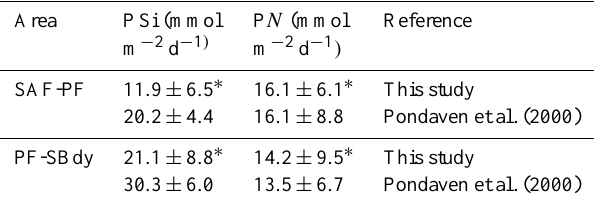
Table 2. Comparison of the estimated daily net production rate